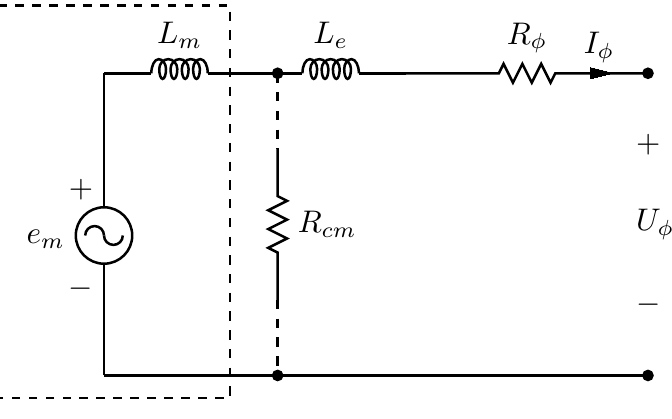
Figure 7. Per-phase equivalent circuit of the